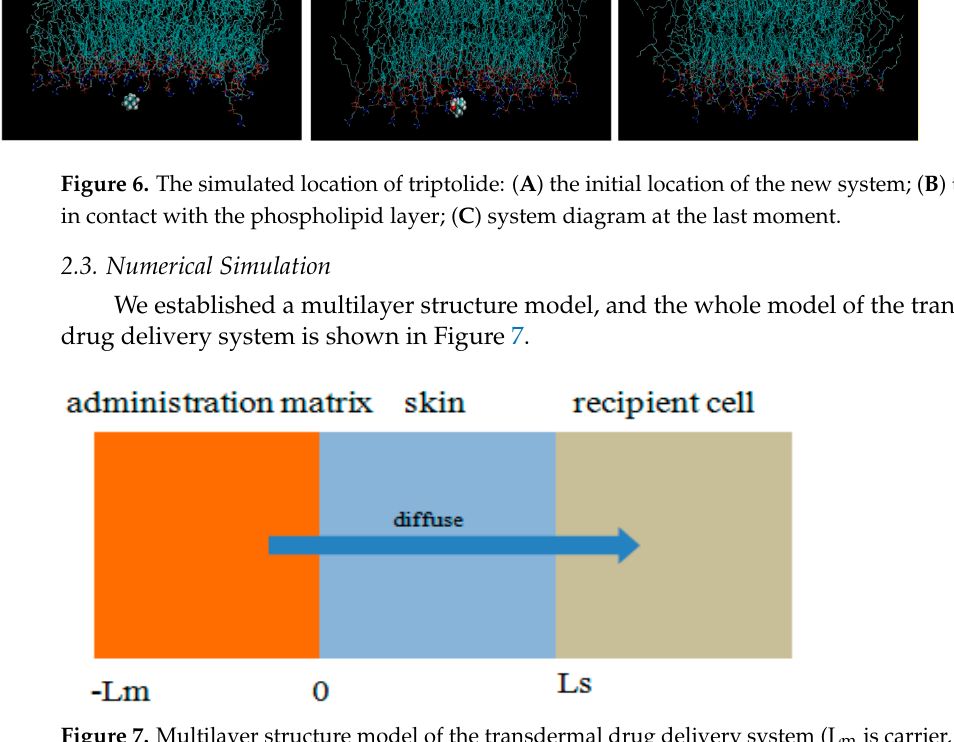
Figure 7. Multilayer structure model of the transdermal drug delivery system (L m is carrier, and L s is stratum corneum).